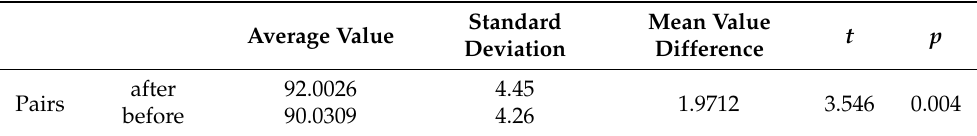
Table 8. Result of paired t -test analysis. p = 0.004 indicates that the mean values of the two groups of data show significant